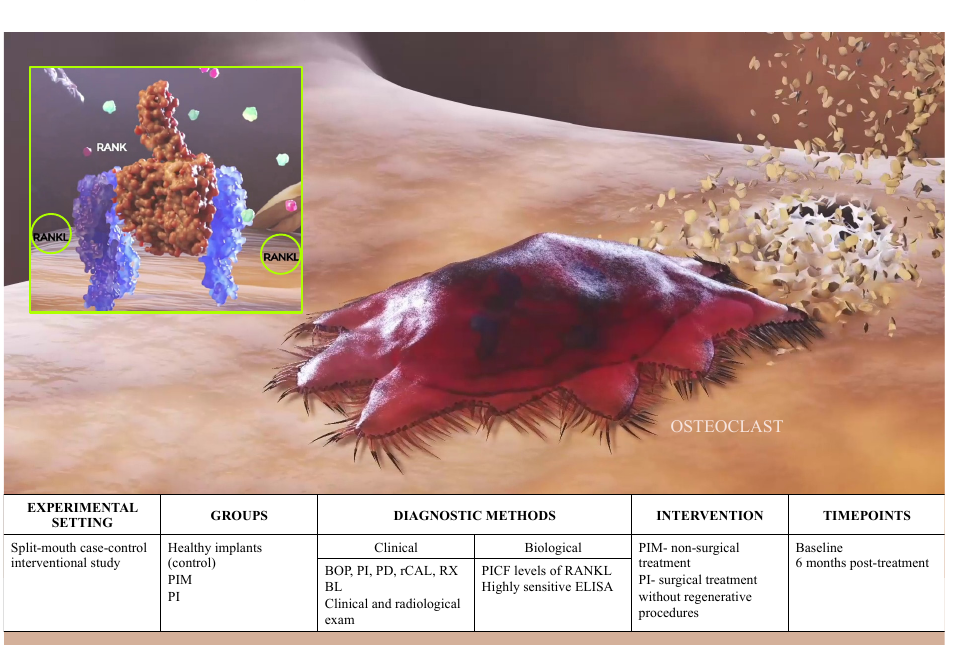
Figure 1. Graphical scheme of the study design.